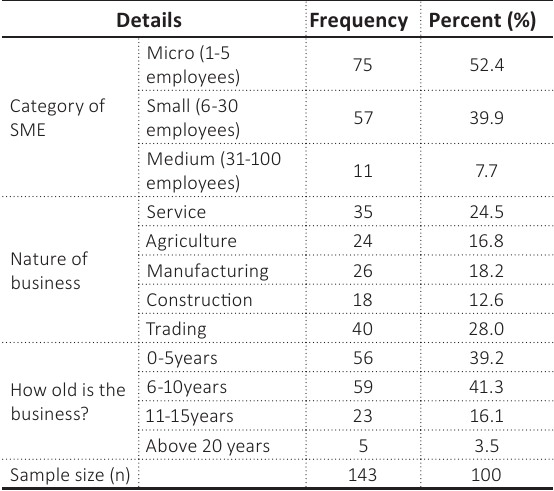
Table 1 (cont.). Socio-demographic profile of